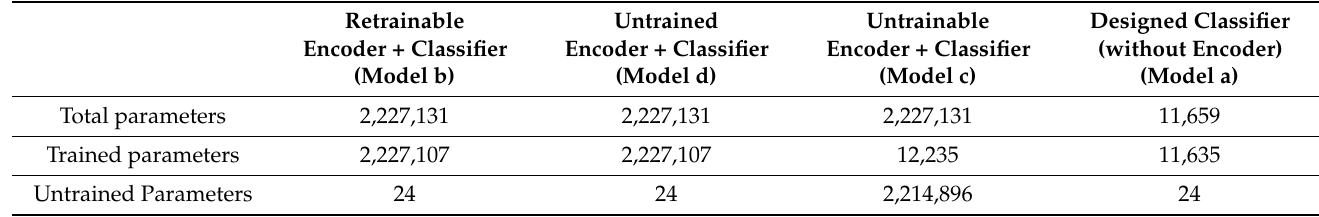
Table 2. The total number of trained and untrained parameters.